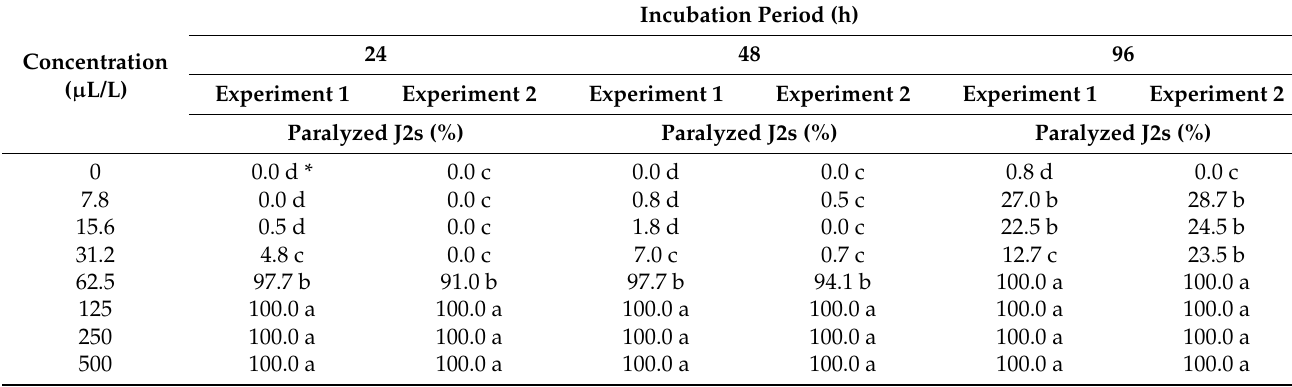
Table 3. Motility percentages of M. javanica J2s after immersion in Cuminum cyminum seed essential oil at 0, 7.8, 15.6, 31.2, 62.5, 125, 250, and 500 µ L/L concentrations for 24, 48, and 96 h exposure